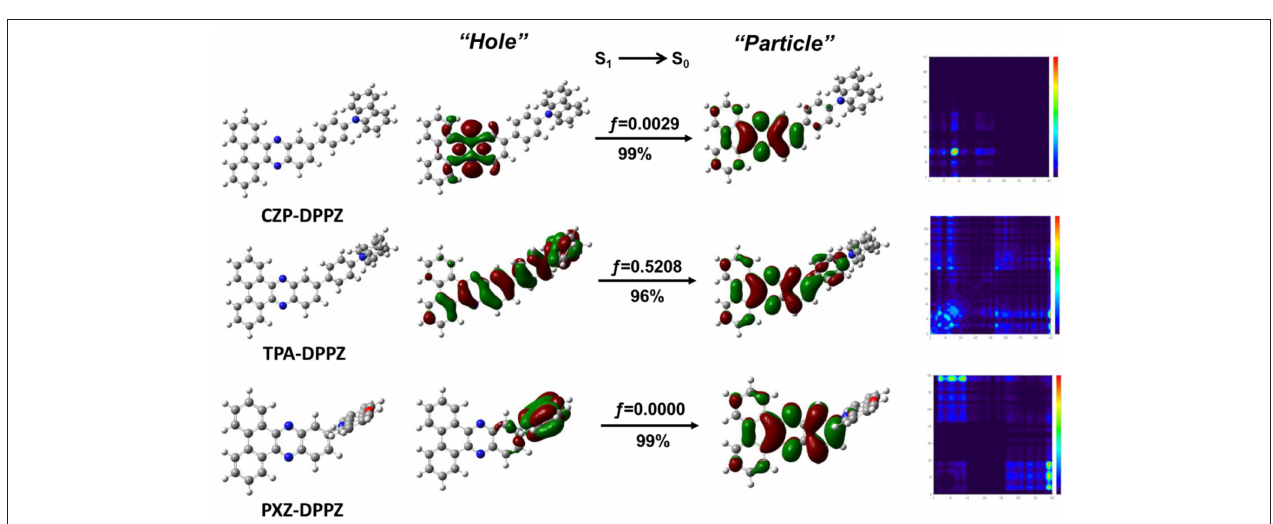
FIGURE 2 | NTO and transition density matrix of the S 1 state for CZP-DPPZ, TPA-DPPZ and PXZ-DPPZ on S 1 -geometry. Herein, f represents for the oscillator strength; “Hole” and “Particle” of the NTO represent for the hole- and the electron-moieties, respectively. The details of the calculation can be found in the supporting